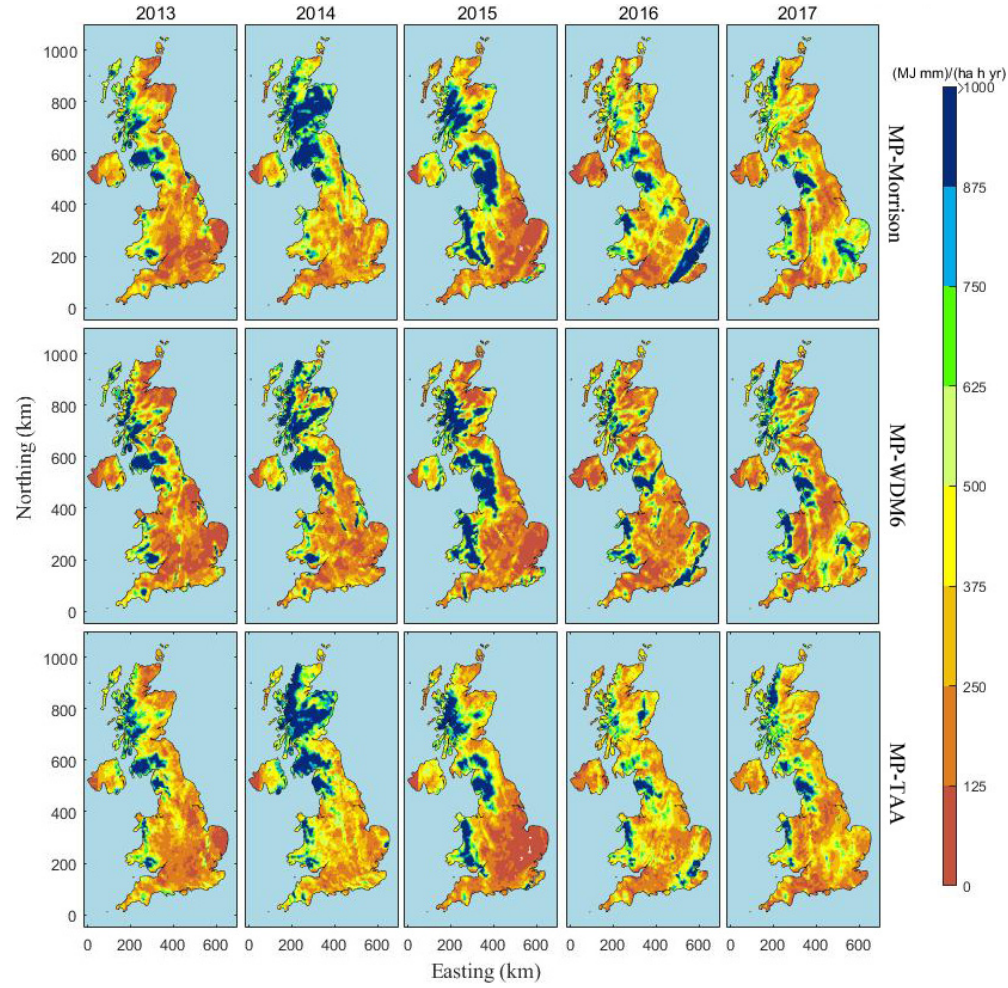
Figure 9. WRF-derived annual rainfall erosivity maps of the whole UK for different years.